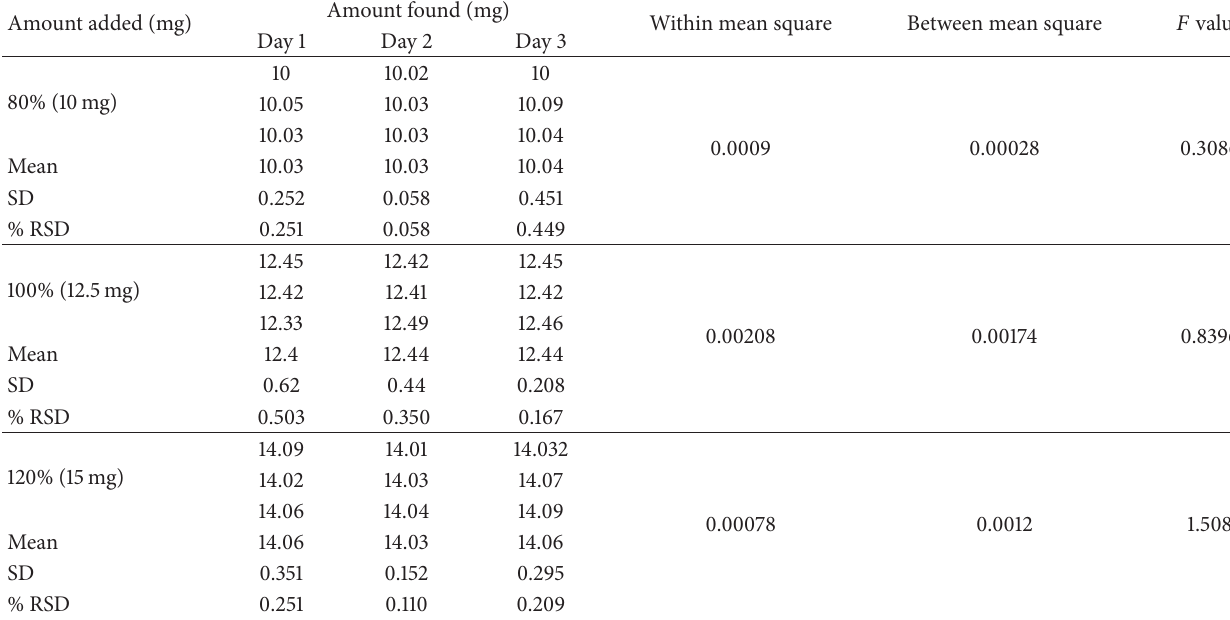
Table 5: Accuracy and precision